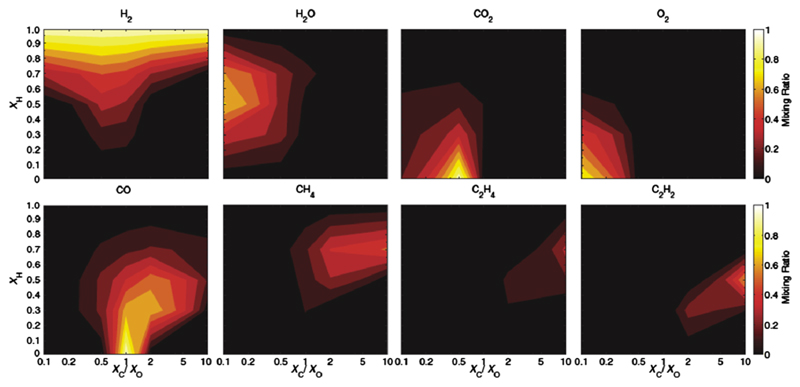
Mixing ratios for important atmospheric constituents vertically averaged over the pressure range 1–100 mbar from a disequilibrium thermo/photochemistry model of the super-Earth GJ 1214b, as a function of the bulk atmospheric H mole fraction (XH , where smaller values correspond to higher metallicities) and the C/O ratio (XC/XO). Figure from Hu and Seager (2014)